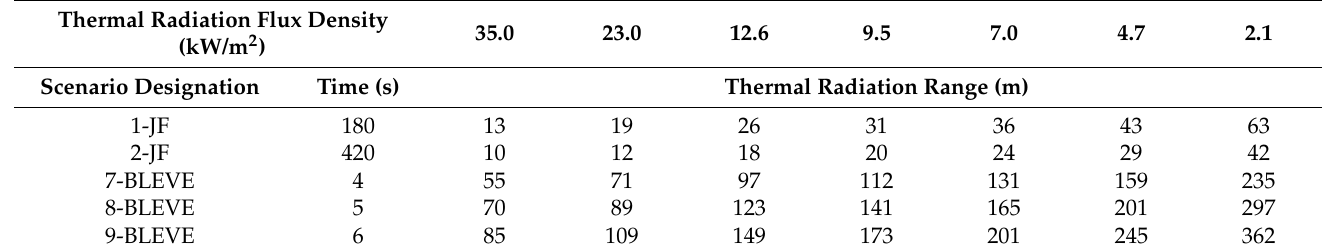
Table 6. Thermal radiation range.